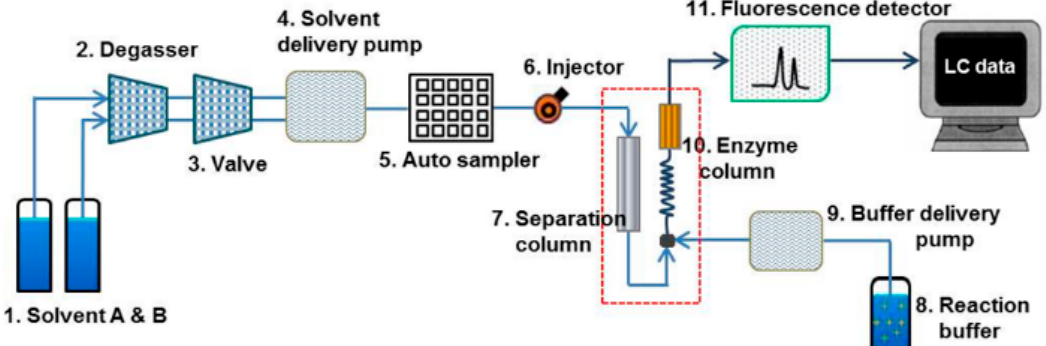
Figure 1. High-Performance Liquid Chromatography (HPLC) setup with a fluorescence detector (excitation: 345 nm, emission: 470 nm) for the analysis of bile acids. The Schematic diagram of bile acids analysis system shows the Waters ® 2695 Alliance HPLC system equipped with analysis components ( 1 through 11 ). The flow direction through column sets ( 7. Separation column, 10. Enzyme reaction column) is indicated by arrows. The flow from the component 7 (separation column) is merged with flow from the component 9 (reagent pump), and then the mixtures of mobile solvents with the separated eluents and reagent solution comes through the reaction coil into the Enzymepakcolumn (component 10 ). Finally, the flow from the Enzyme column goes into the fluorescence detector (component 11 ).